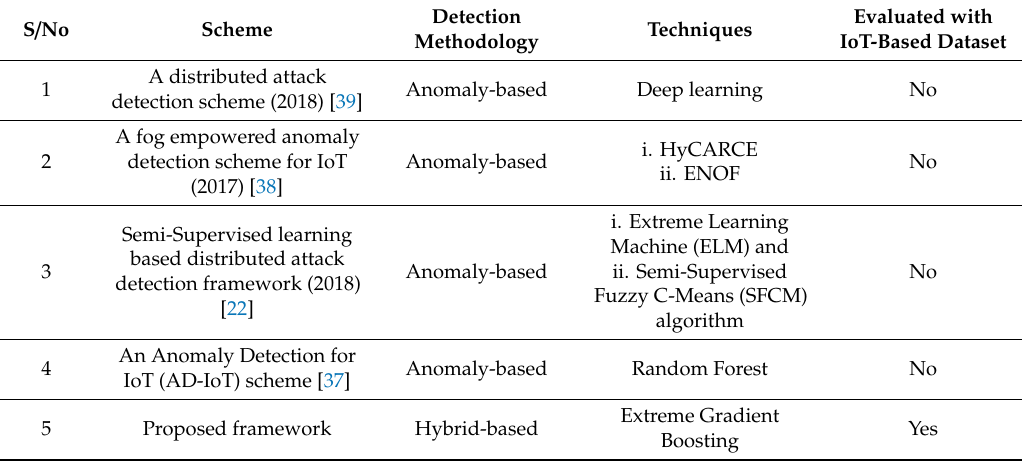
Table 2. Comparison of some fog-based schemes with the proposed